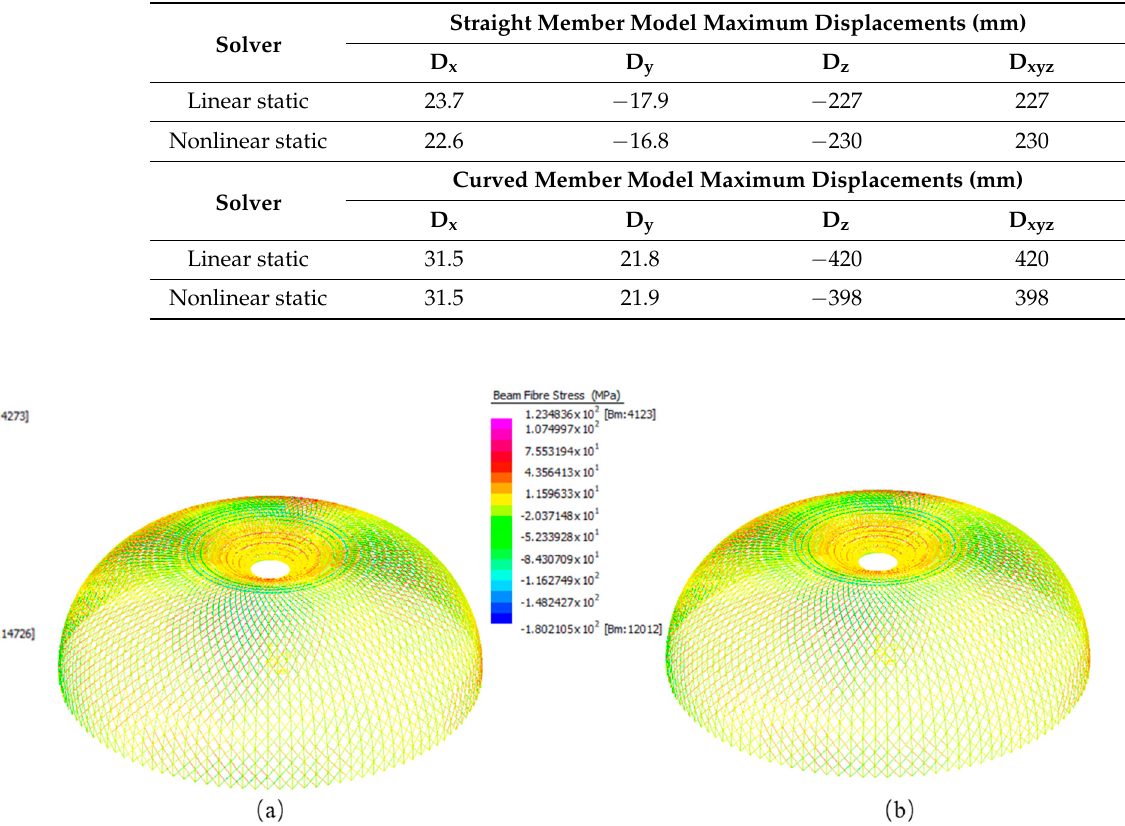
Table 9. Displacements under 1.2G + W.